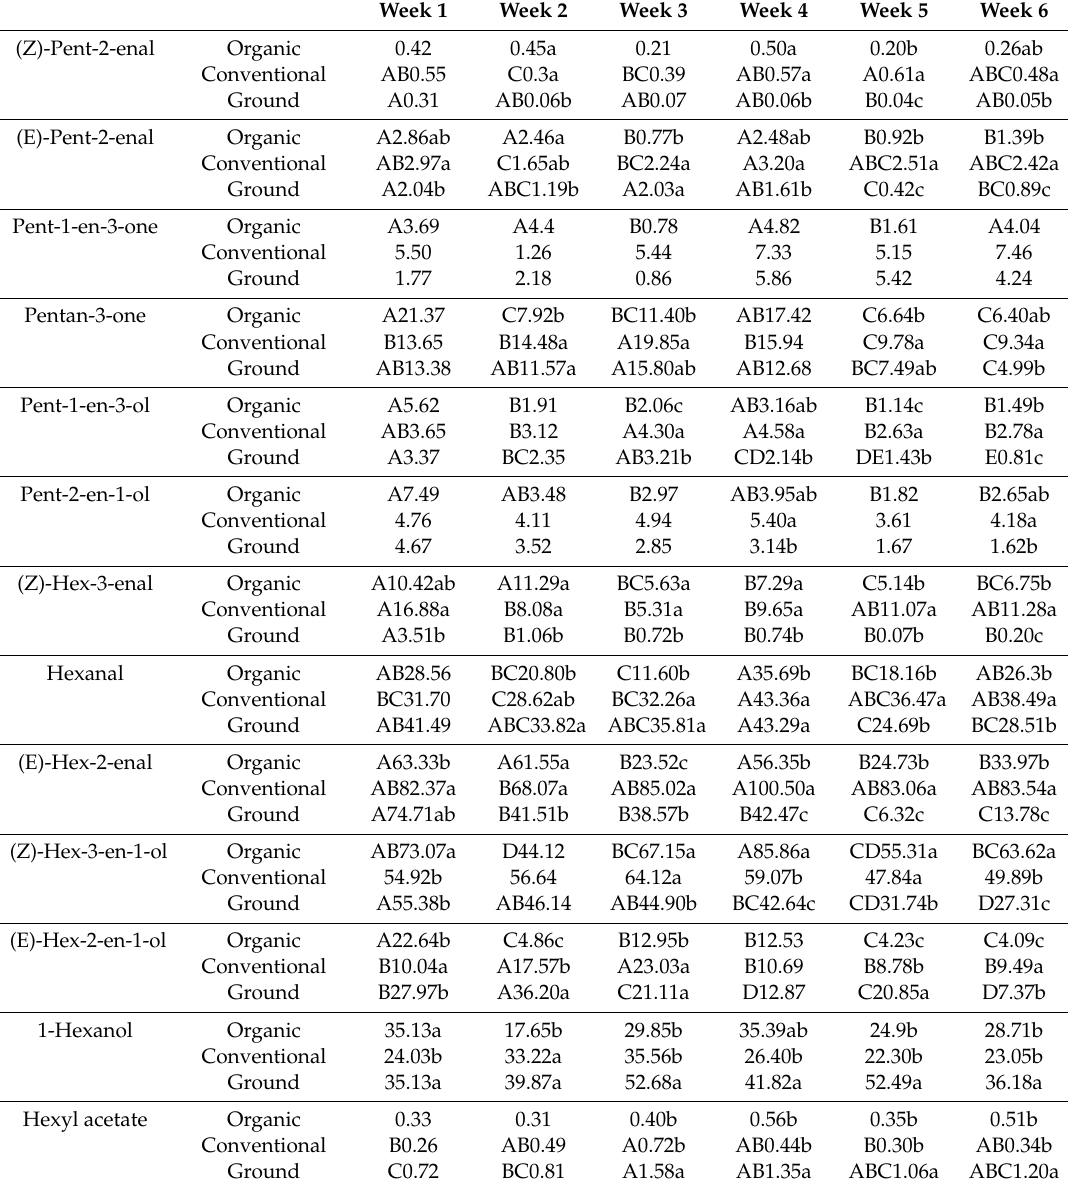
Table 3. Results (means and significance *) for the most representative C5 and C6 LOX volatile compounds of the Verdial de Badajoz oil headspace significantly a ff ected by the organic production, harvesting method and / or harvesting time according to Table